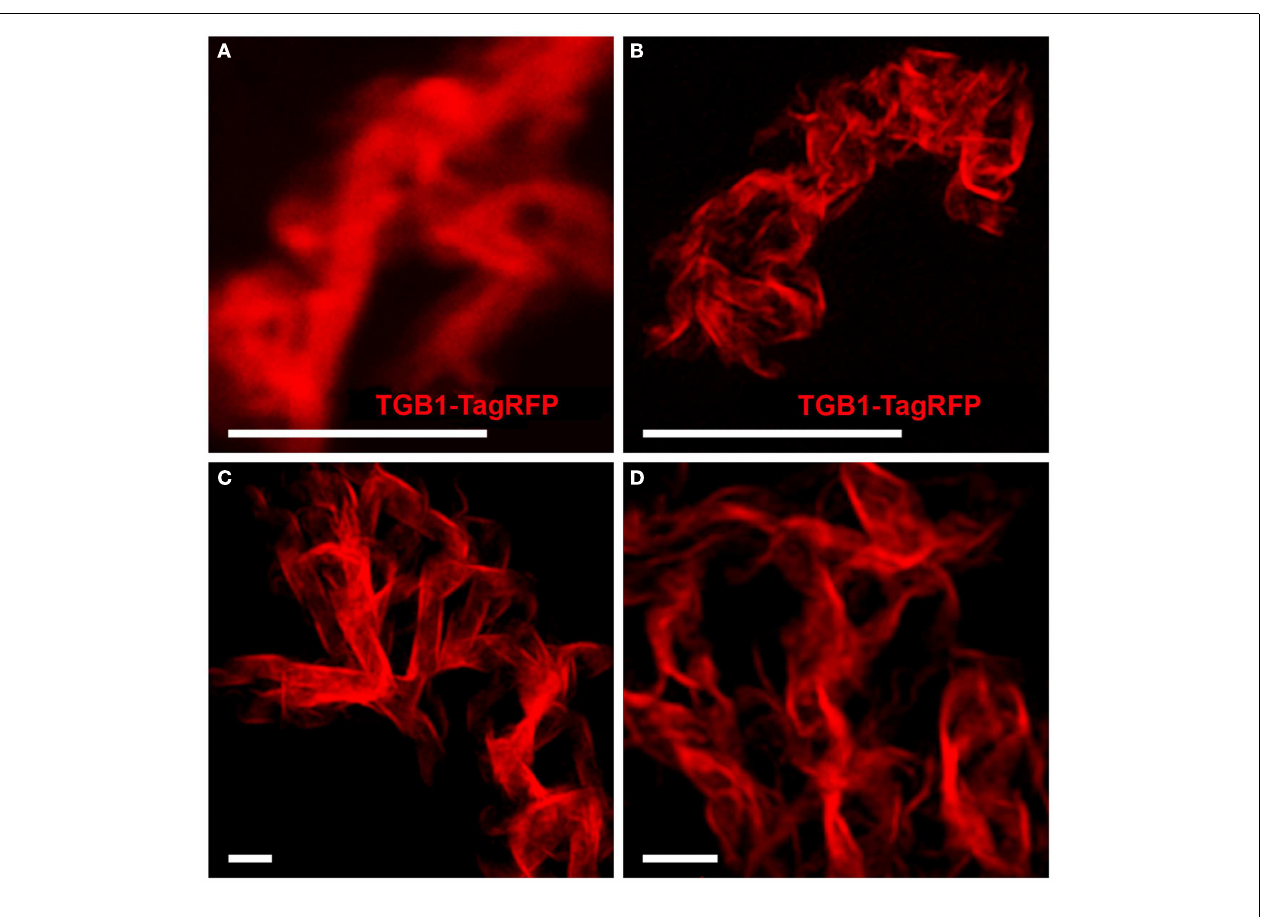
by confocal microscopy. (B–D) 3D-SIM super-resolution images of the same material. (A,B) Shown at the same scale. Bars (A,B) : 5 µ m; (C,D) : 1 µ